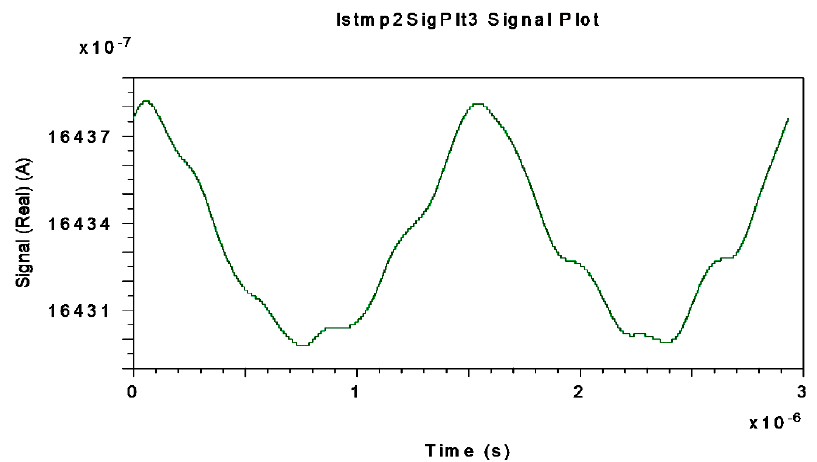
Figure 13. Interferometric current signal obtained at APD-equivalent-photodetector electrical output (after electrical BP Filter with f center = 340.83 kHz) when Ω = ±20 °/s is applied to system.